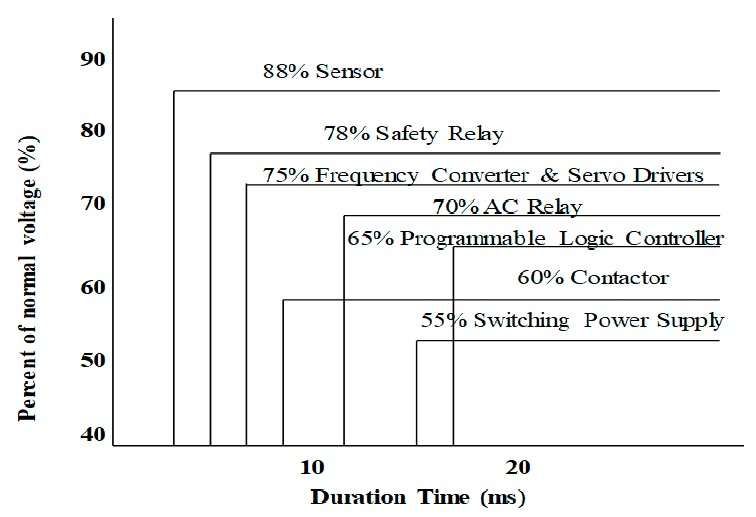
Figure 1. Devices sensitive to voltage variation in the industry.